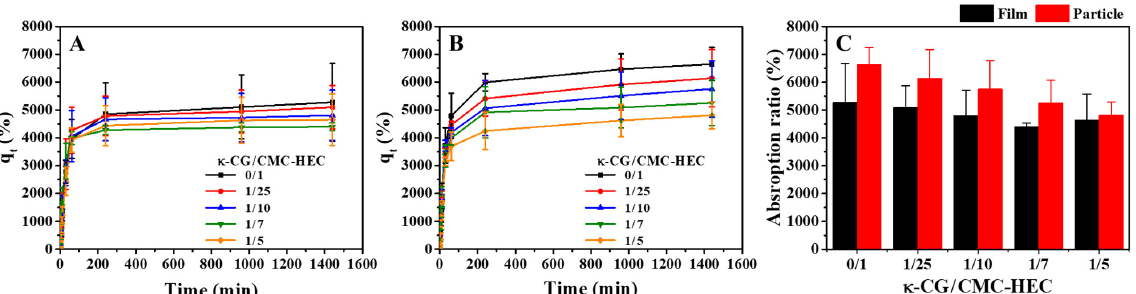
Figure 6. Effect of the absorption time on the water ‐ absorption capacity of the hydrogel ( A ) films and ( B ) particles with different compositions in deionized water (pH 7) at 25 °C. ( C ) Effect of the κ‐ ( B ) particles with different compositions in deionized water (pH 7) at 25 ◦ C. ( C ) Effect of the κ -CG CG content on the maximum water ‐ absorption capacities of the hydrogel films and particles in de ‐ content on the maximum water-absorption capacities of the hydrogel films and particles in deionized ionized water (pH 7) at 25 °C. water (pH 7) at 25 ◦ C.